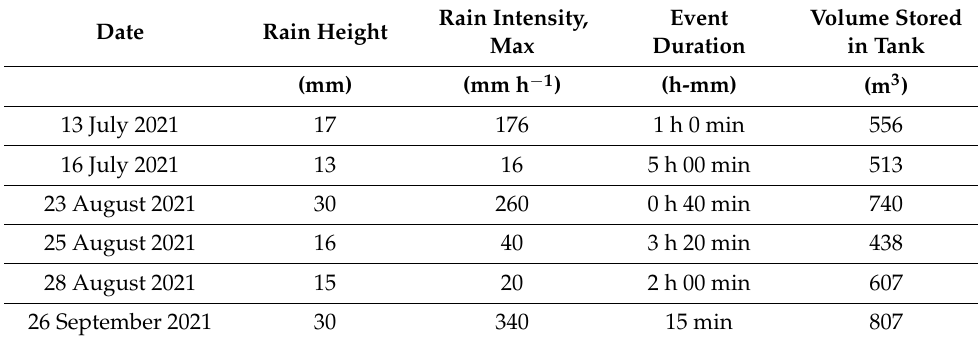
Table 1. Rainfall and wastewater storage in the tank in summer